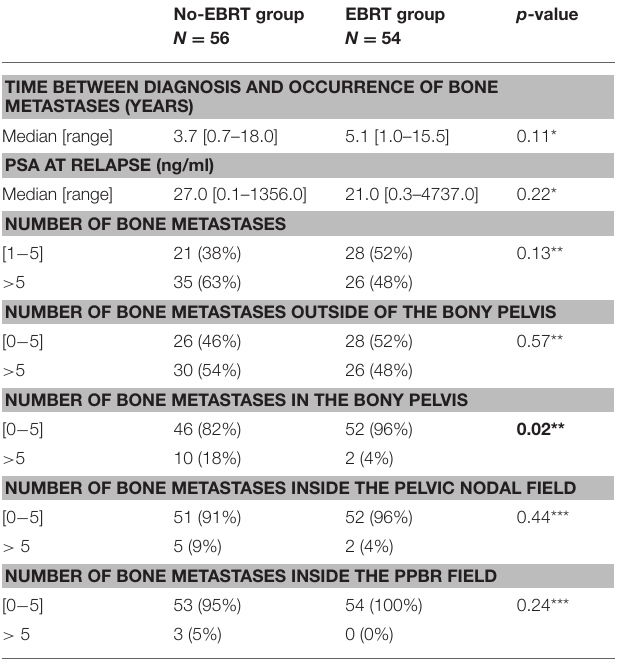
TABLE 2 | Description of the incidence of bone metastases according to the treatment